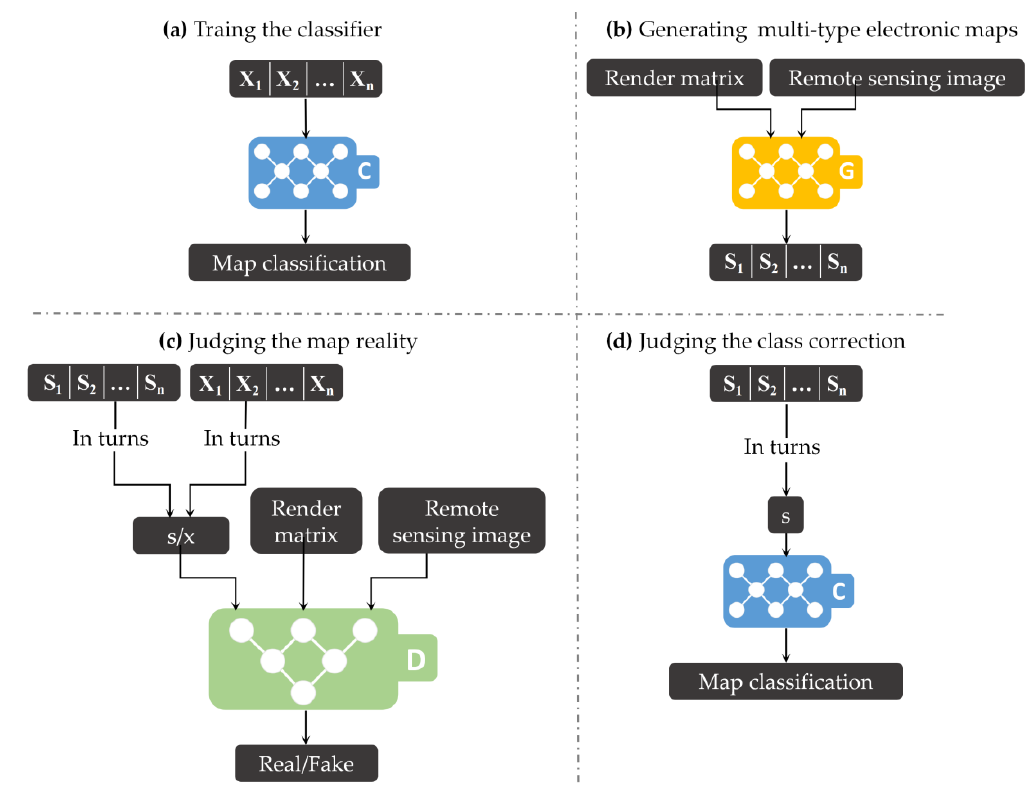
Figure 3. The overall architecture of Map Generative Adversarial Networks (MapGAN), consisting of three modules: a discriminator, D , a generator, G , and a classifier, C . ( a ) We trained classifier C to have map classification capabilities using n types of real electronic maps. ( b ) G outputs the generated n type electronic maps based on remote sensing images and the render matrix, ( c ) D tries to distinguish between real and generated maps corresponding to remote sensing images and the render matrix. ( d ) C tries to judge the category of each generated map.